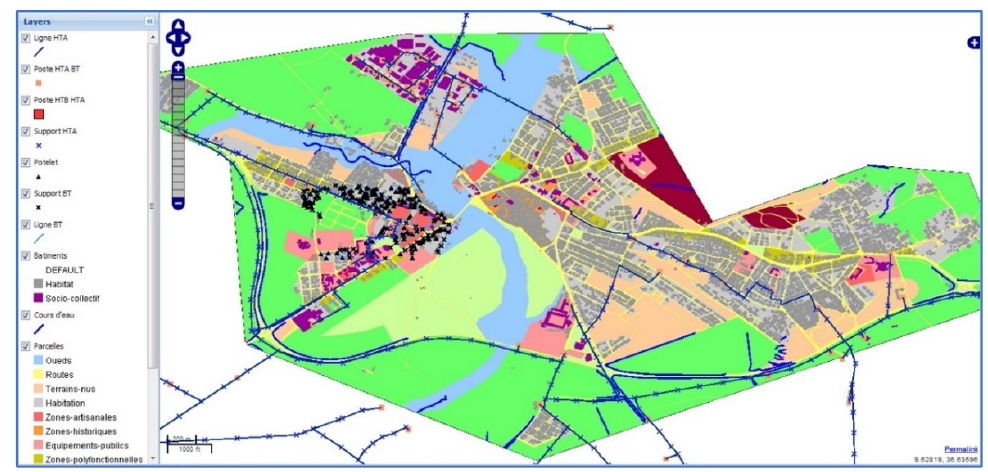
Figure 9. Medjez El Bab Municipality web cartographic interface.